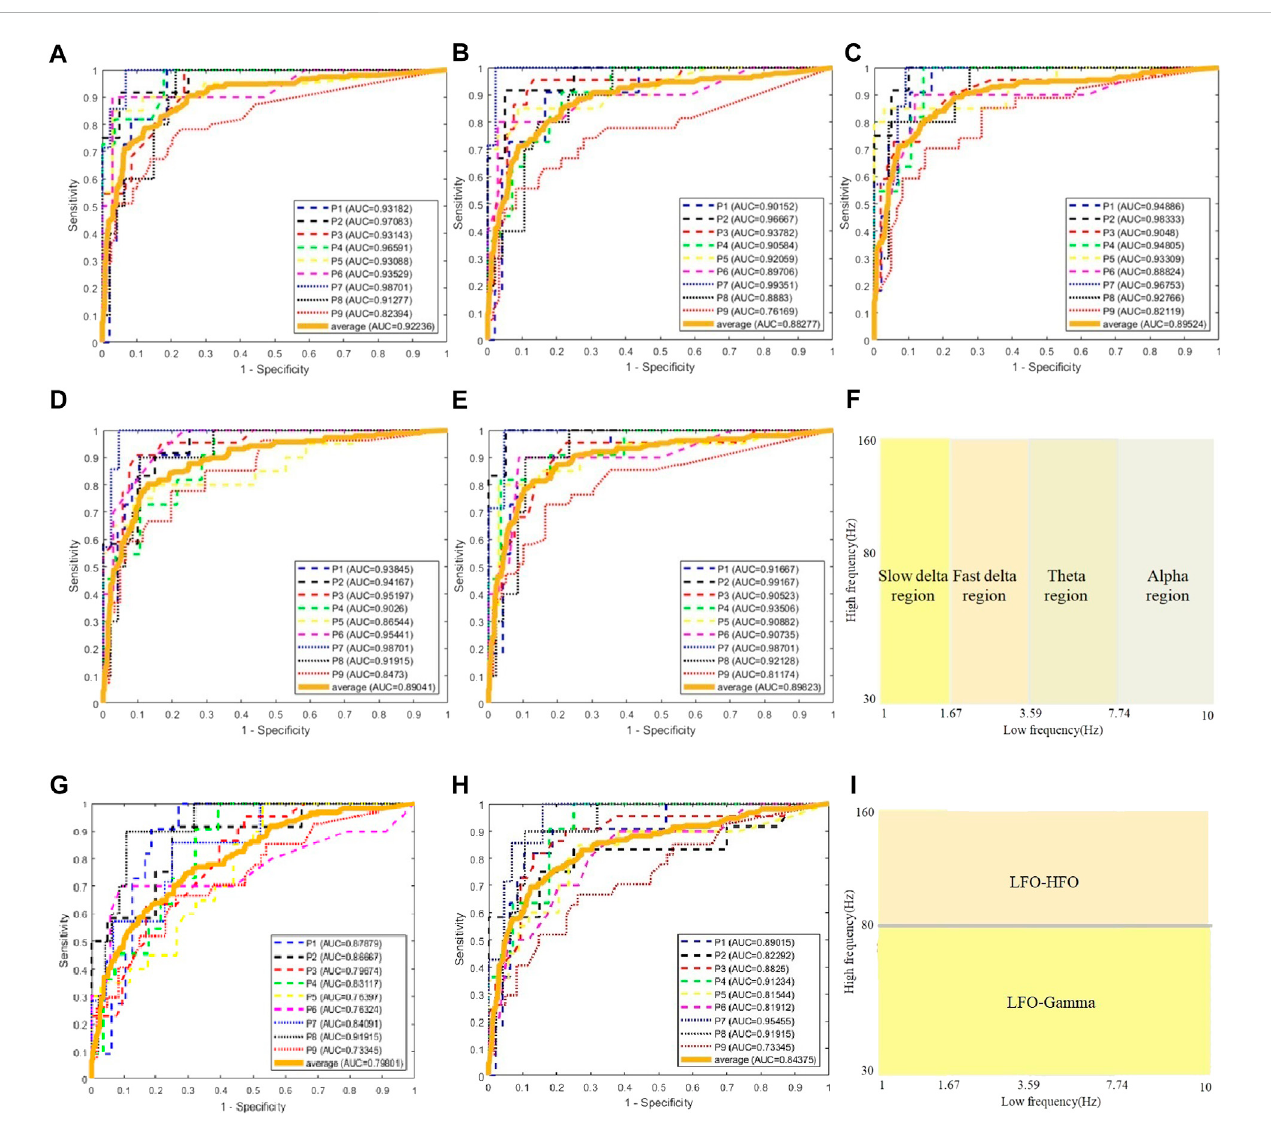
FIGURE 3 ROCcurvesofCV-CNNonCV-PACdataset. (A) CV-PACwithfulllow-frequencyband. (B) CV-PACwithoutslowdelta. (C) CV-PACwithoutfastdelta. (D) CV-PAC without theta (E) CV-PAC without alpha. (F) PAC regions are divided into four low-frequency bands. (G) CV-PAC withLFO-gamma. (H) CV-PACwith LFO-HFO. (I) PAC is divided into LFO-gamma and LFO-HFO